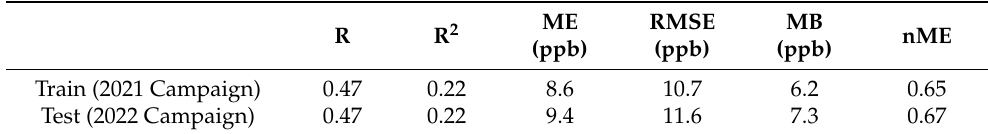
Table 3. Evaluation metrics for the uncorrected ENSENSIA measurements of ozone against the reference. The metrics were calculated based on hourly-averaged values.